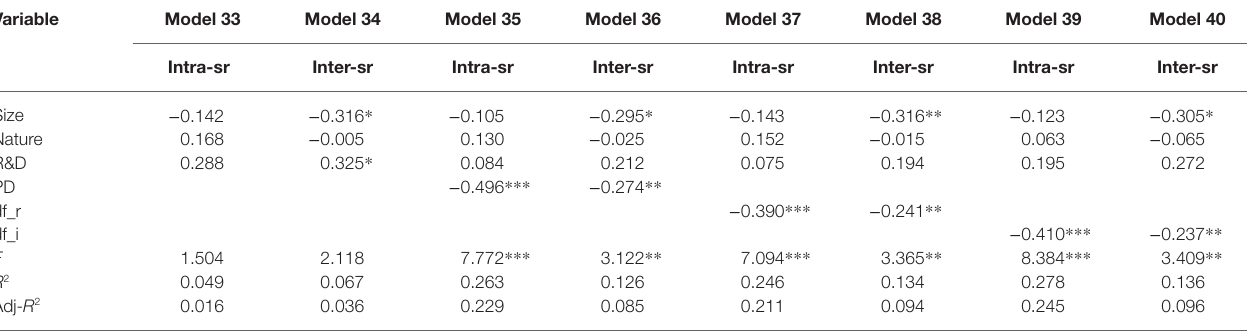
TABLE 8 | The direct relationship between psychological distance, divisive faultlines, and subgroup reciprocity in the technological innovation network (Group 2; N = 92). Variable